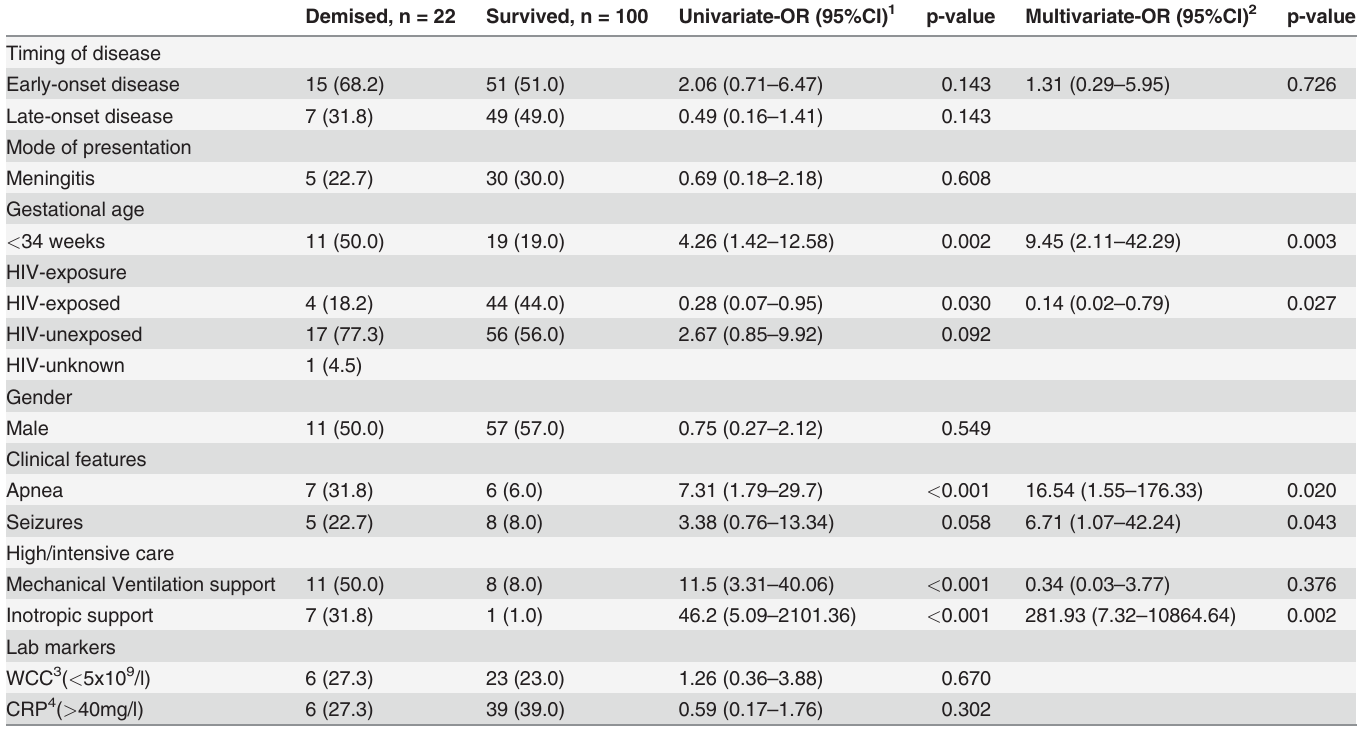
Table 3. Predictors of mortality from invasive Group B streptococcus (GBS)